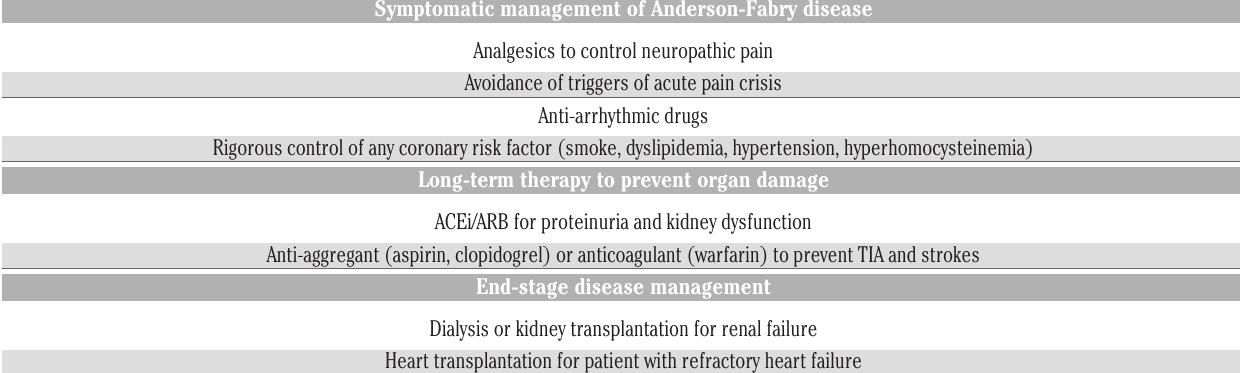
Table 3. Conventional medical treatment in Anderson-Fabry